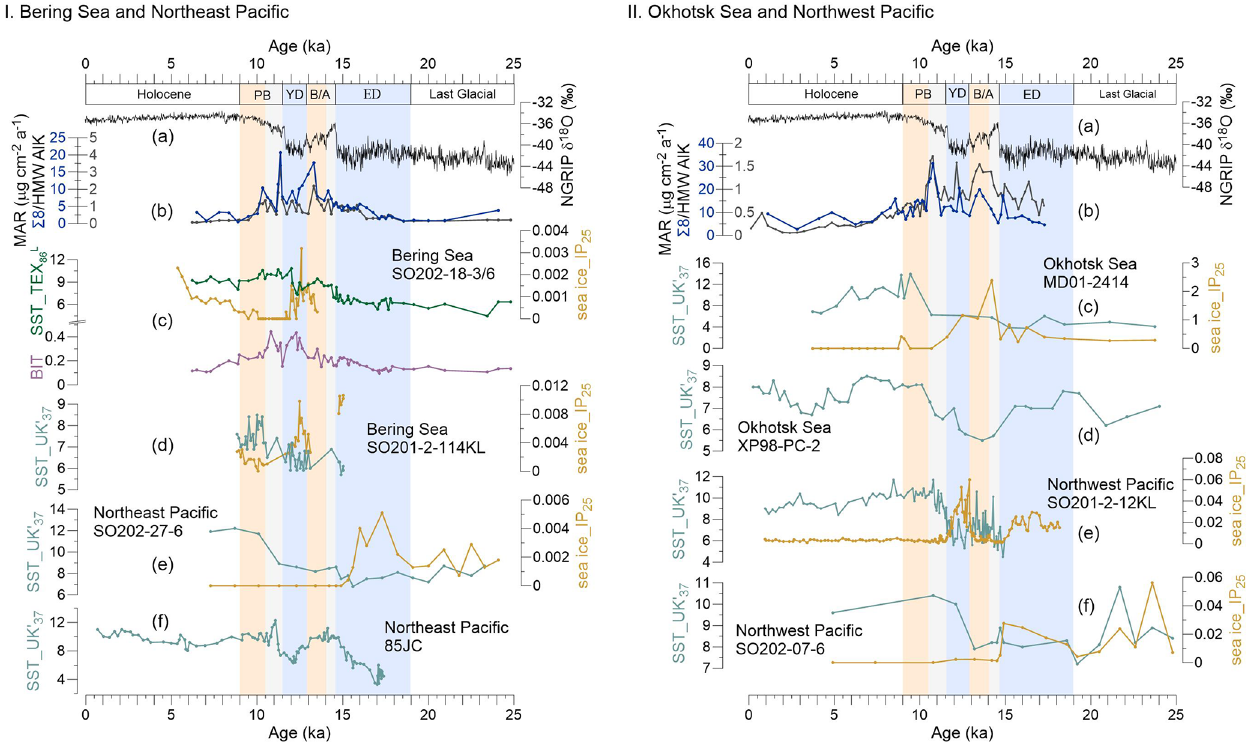
Figure 3. Records of sea surface temperature (SST) and sea ice (IP 25 ) in the Bering Sea and northeastern Pacific and the Okhotsk Sea and northwestern Pacific during the past 25kyr. (a) NGRIP- δ 18 O from Greenland (Rasmussen et al., 2008). (b) MAR of biomarkers. I (c) The green line reflects SST (TEX L ), and the purple line shows the BIT from this study, SO202-18-3/6. The orange line denotes the IP 25 obtained 86 for this core by Méheust et al. (2018). (d) SST and IP 25 for core SO202-2-114KL (Max et al., 2012; Méheust et al., 2016). (e) SST and IP 25 for core SO202-27-6 in the northeastern Pacific (Méheust et al., 2018). (f) SST for core 85JC (Praetorius et al., 2015). II (c) SST and IP 25 of the core MD01-2414 in the Okhotsk Sea (Lattaud et al., 2019; Lo et al., 2018). (d) SST for core XP98-PC-2 (Seki et al., 2014b). (e) SST and IP 25 for core SO201-2-12KL in the northwestern Pacific (Max et al., 2012; Méheust et al., 2016). (f) SST and IP 25 for core SO202-07-6 (Méheust et al., 2018). The units of the SST and IP 25 are degrees Celsius and micrograms per gram sediment, respectively. Blue boxes represent intervals with prevailing colder climate conditions during the early deglaciation (ED) and Younger Dryas (YD); orange boxes are for the warm phases Bølling–Allerød (B/A) and Pre-Boreal (PB). Gray boxes highlight the periods of meltwater pulse 1A (MWP-1A) and 1B